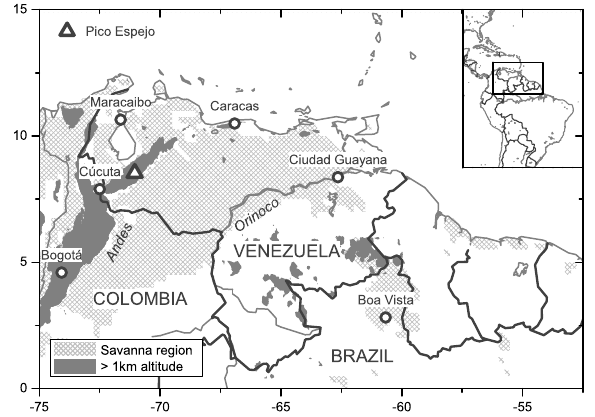
Fig. 1. Map of the northern part of South America. The triangle indicates the position of the Pico Espejo Atmospheric Research Station Alexander von Humboldt (4765ma.s.l.) in Venezuela.